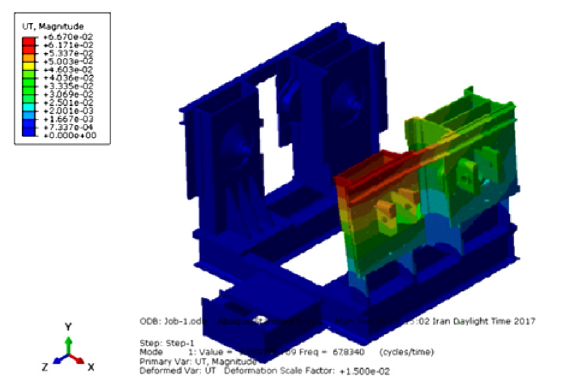
Fig. 5. The first mode of natural